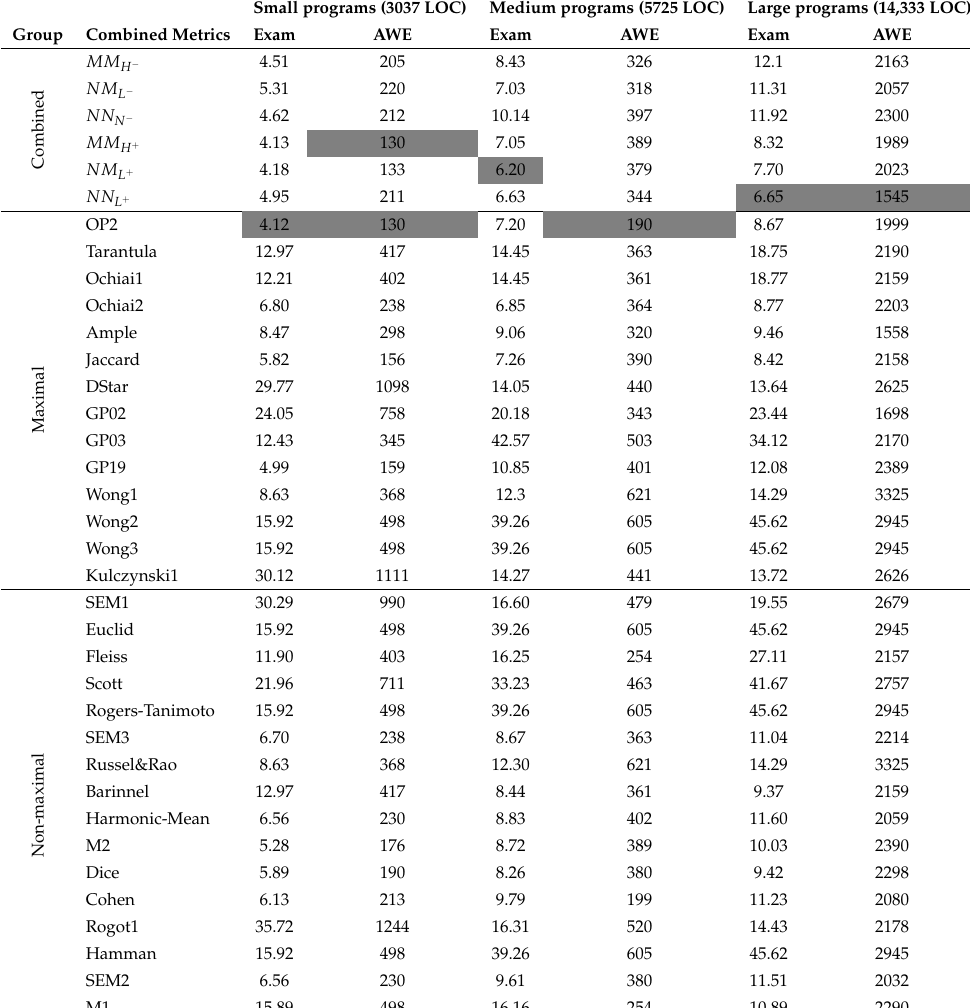
Table 6. Performance comparison of the combined risk evaluation metrics with the standalone risk evaluation metrics. The best metrics for each subject program are highlighted in grey colour for easy